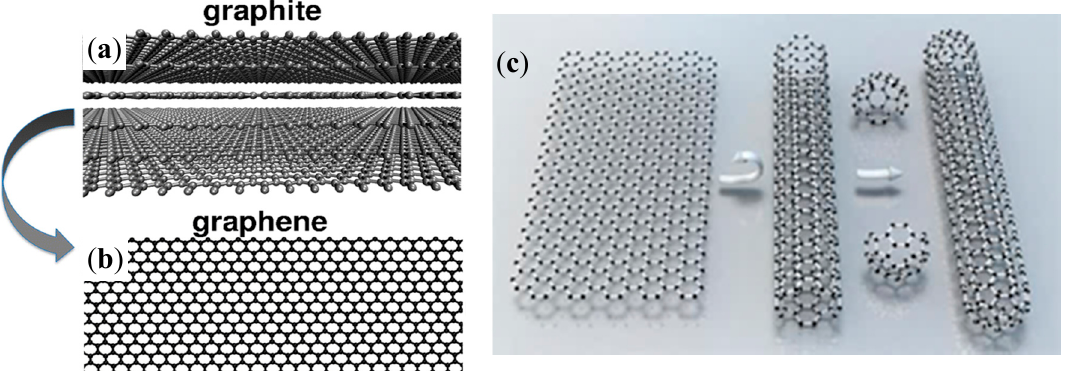
Figure 1. Different allotropes of carbon: ( a ) 3D graphite, ( b ) 2D graphene, ( c ) 1D carbon nanotubes, and 0D carbon fullerenes.